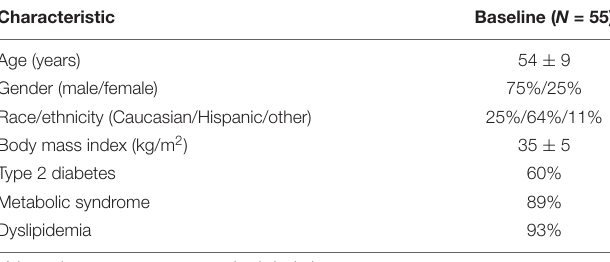
TABLE 1 | Baseline patient